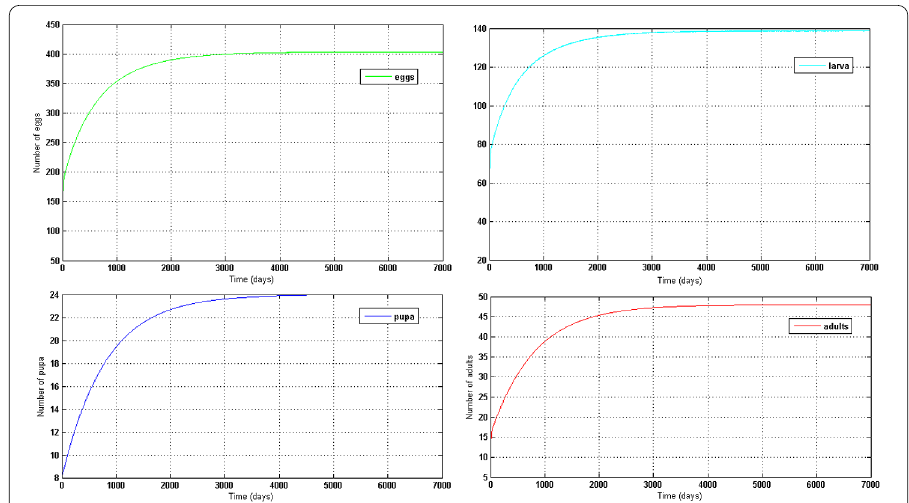
Figure 4 Evolution of eggs, larvae, pupae and adults for b = 10.7, S E = 0.4, d E = 0.36, s L = 0.5, d L = 0.34, s P = 0.3, d P = 0.17 and f m = 0.15. We get r = 14.2644, which is greater than unity